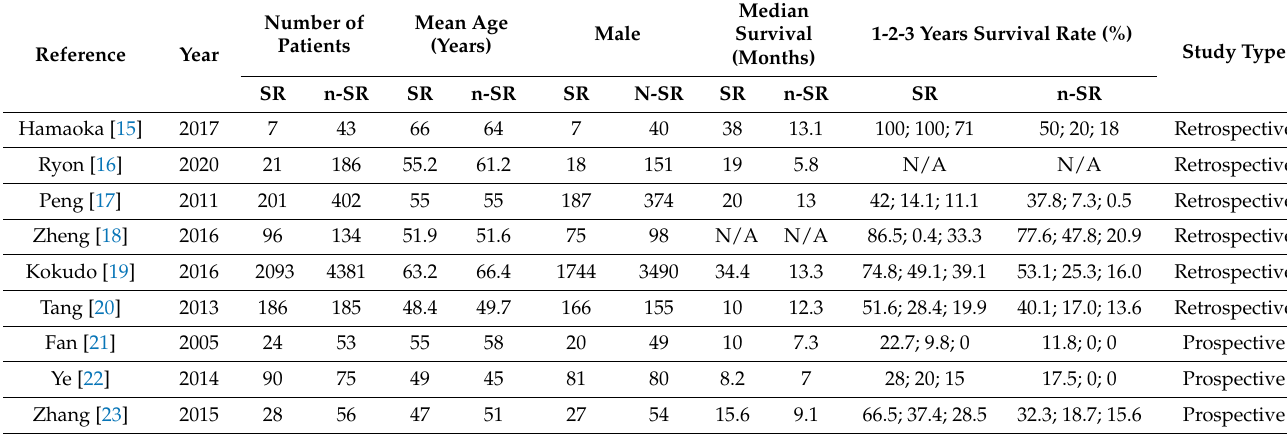
Table 2. Characteristics of the patients.